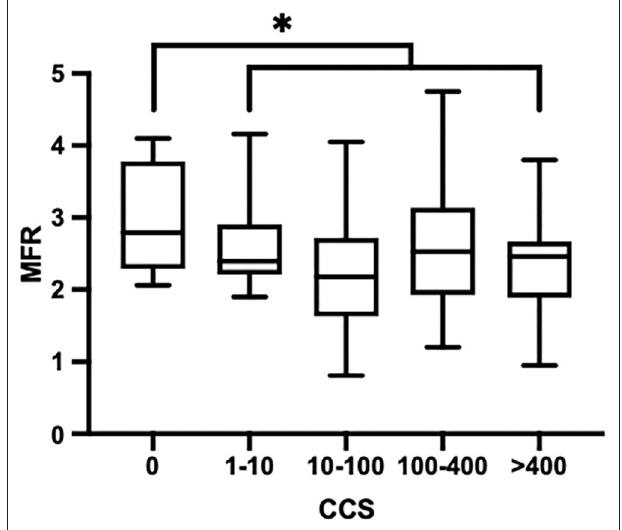
FIGURE 4 | Myocardial flow reserve according to coronary calcium score. * p < 0.05.